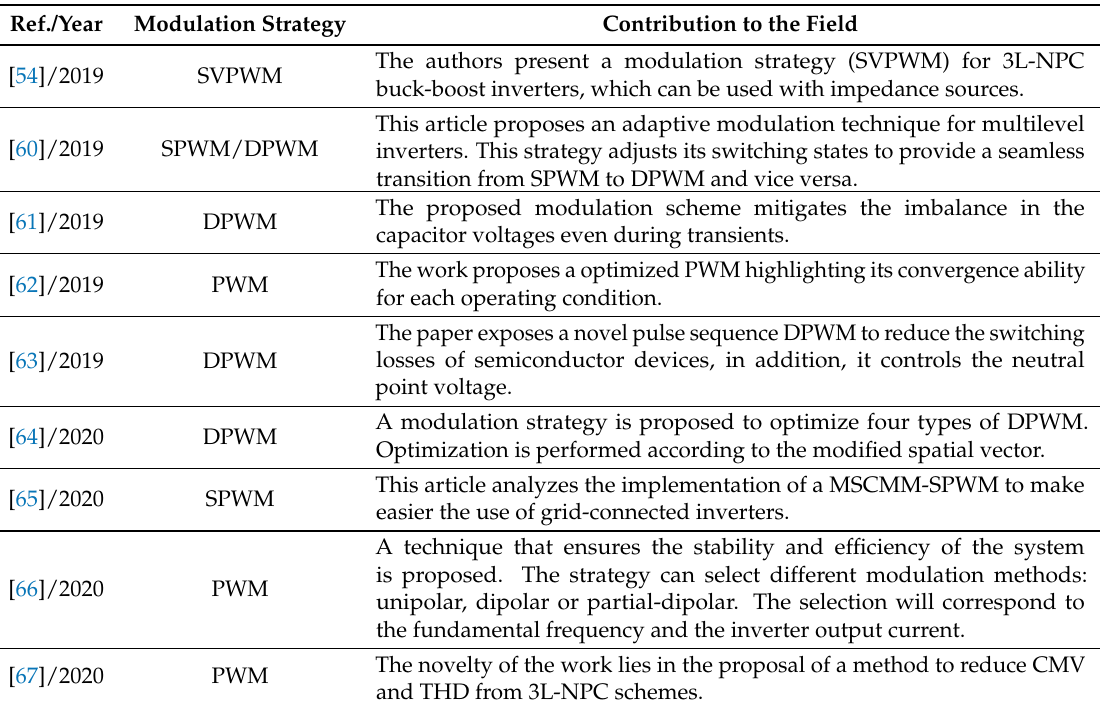
Table 5. Summary of recent works on modulation strategies in NPC